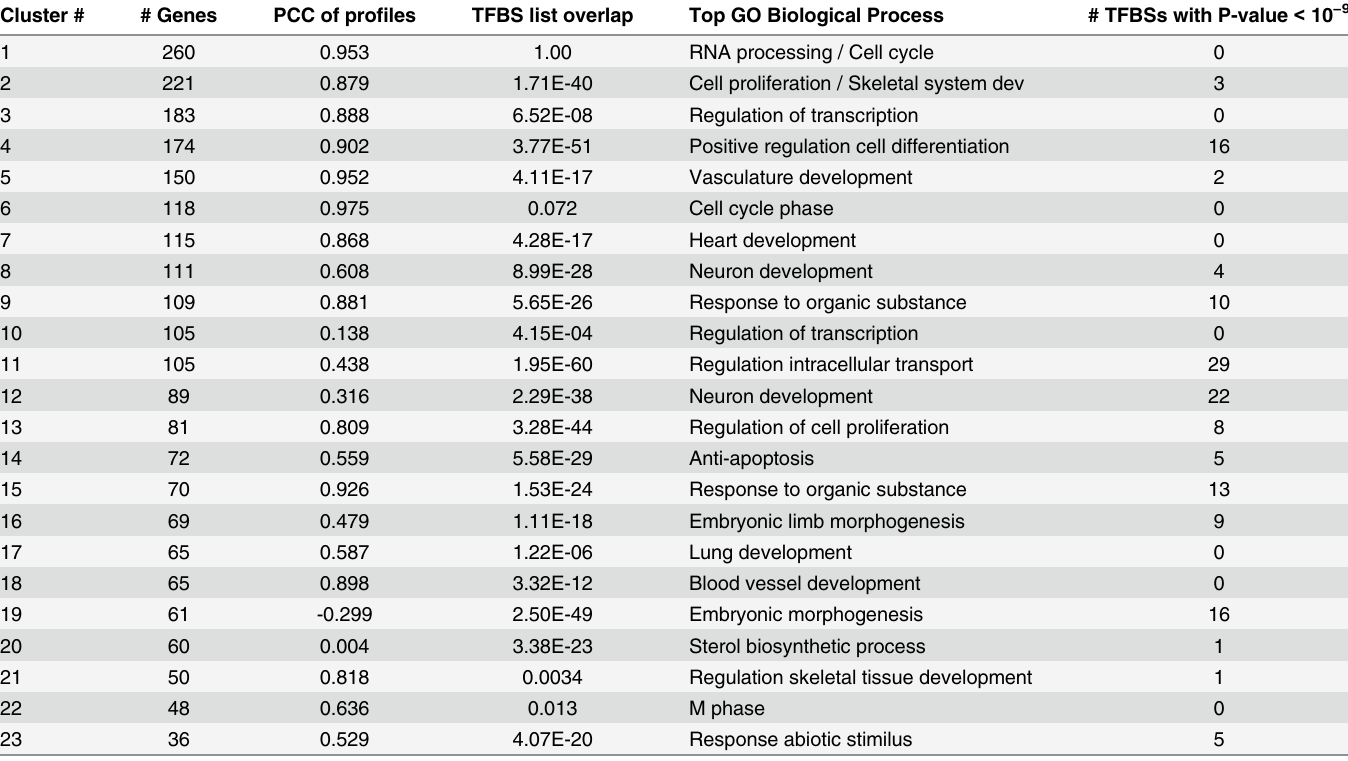
Table 4. Expression and promoter TFBS properties of mESC